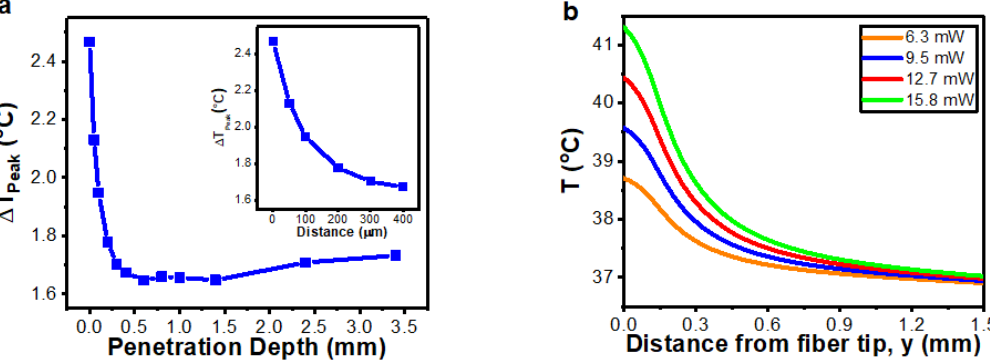
Figure 5. Spatial temperature analysis of the TP optical fiber in the brain. ( a ) Temperature changes of the TP optical fiber with different penetration depths. Each light power was set to 6.3 mW. ( b ) Temperature distribution of the TP optical fiber with a different light power (mW). Penetration depth was set to 1.4 mm.